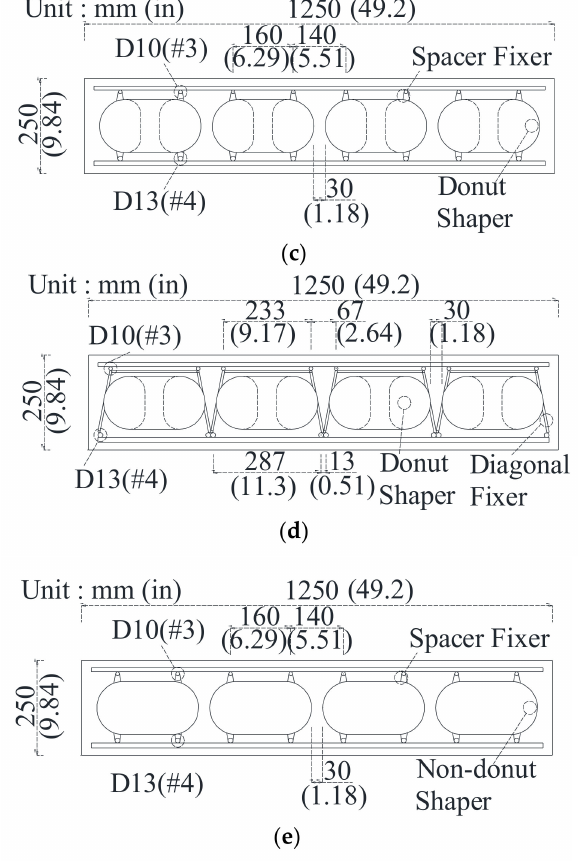
Figure 9. Details of specimens: ( a ) plan and elevation; ( b ) solid; ( c ) OF-V-S-D; ( d ) OF-V-M-D; ( e ) OF-V-S-R.